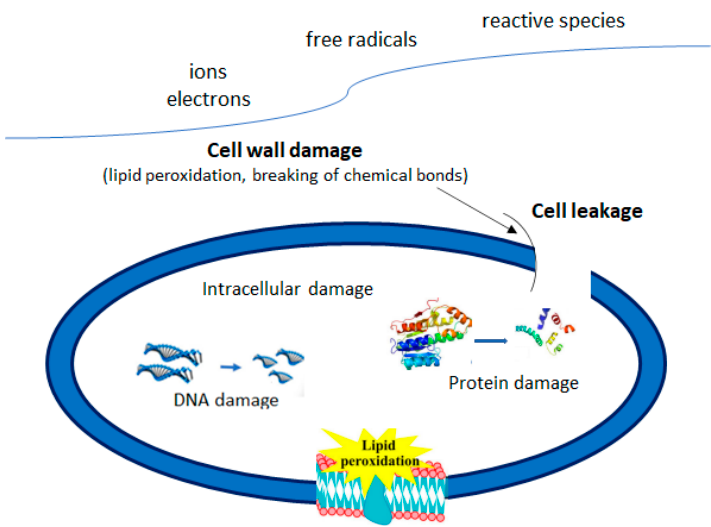
Figure 2. Schematic diagram of the PAW induced inactivation of microbial cells. Adapted from Mandal et al. [12].